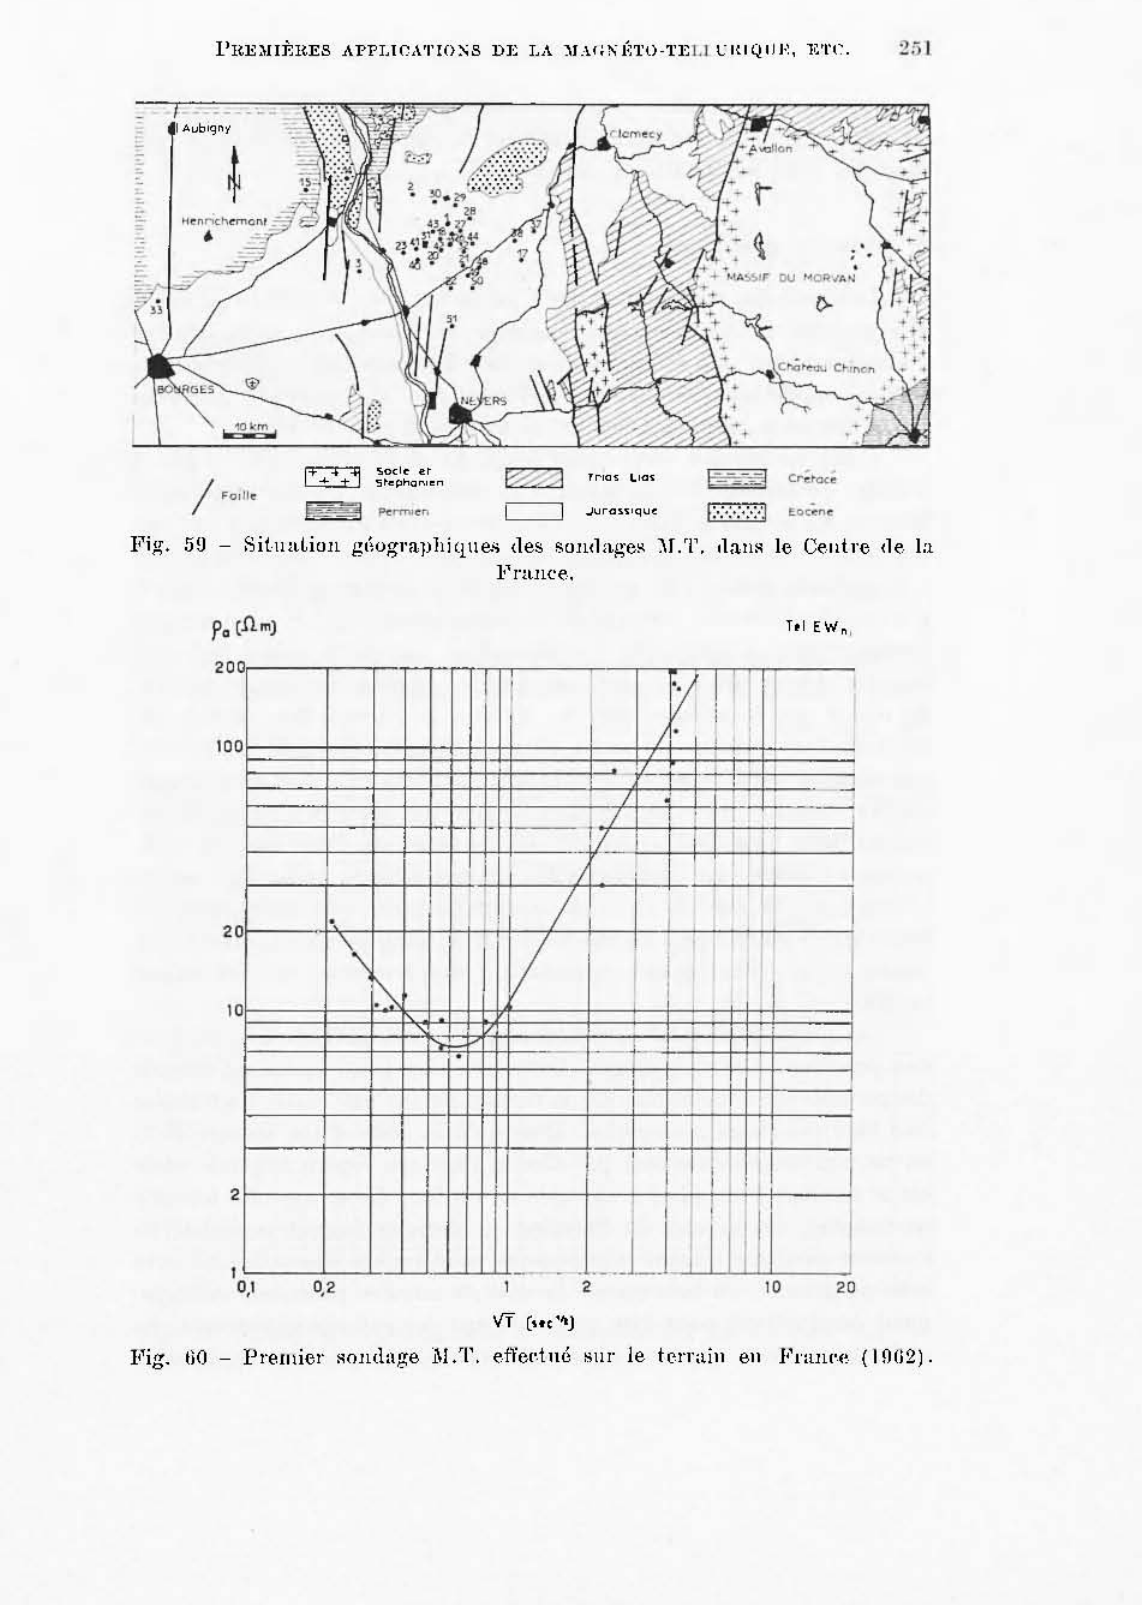
Fig. 59 - SituaLion gl\ogl'a]Jldques <Ies 8oJl(lag'e~ 1f.T. ,lallH le Celltl'e (le